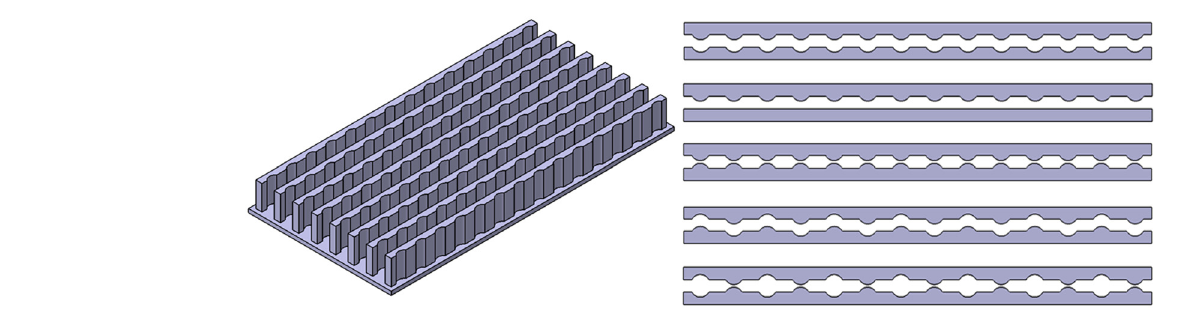
Design: Flow disruption, re - entrant obstruction, and surface roughness